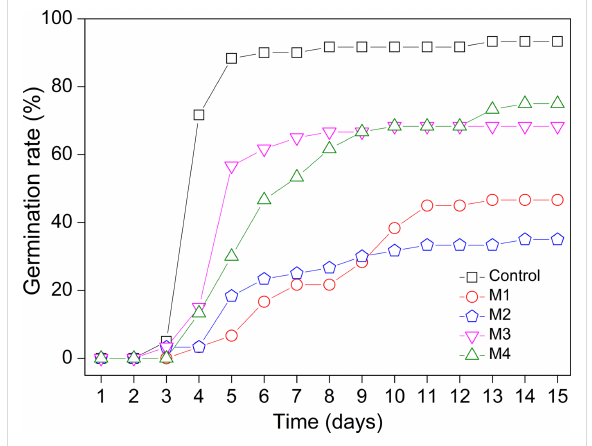
Figure 5: Germination rate in bean seeds covered with: control, M1 = neat alginate, M2 = alginate + ZnAl-CO 3 -LDH, M3 = alginate + NAA, and M4 = alginate +